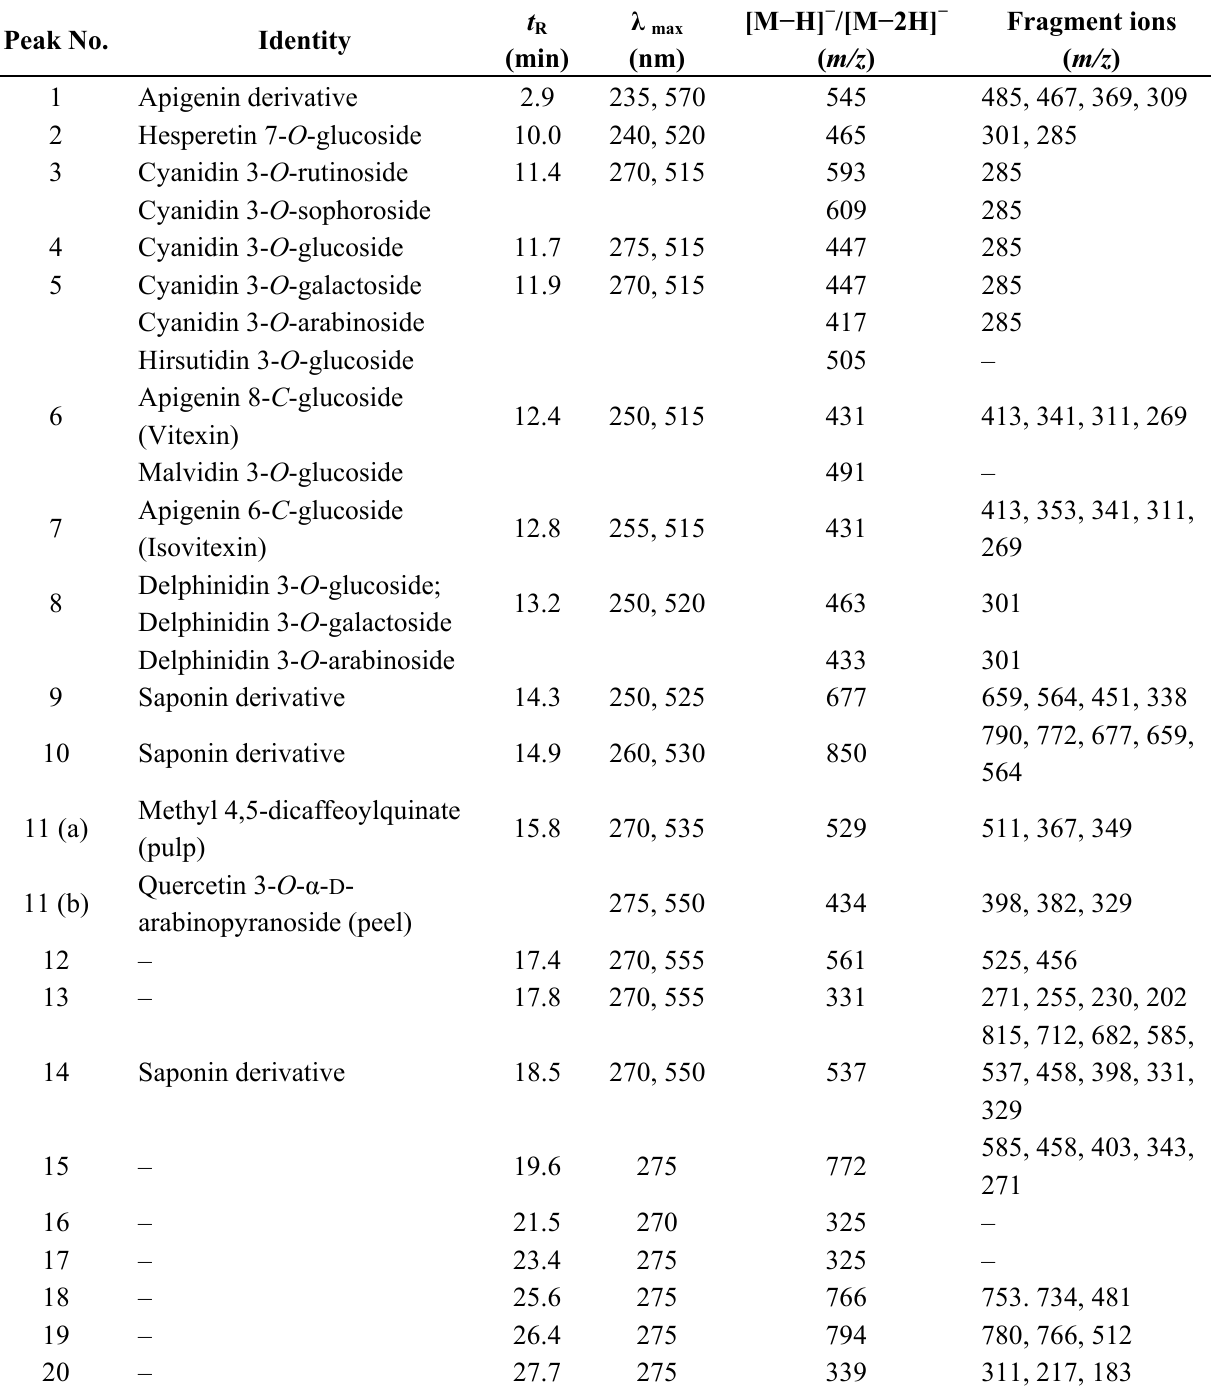
Table 2. Chromatographic and spectral properties of compounds detected in defatted Dabai waste. Peak